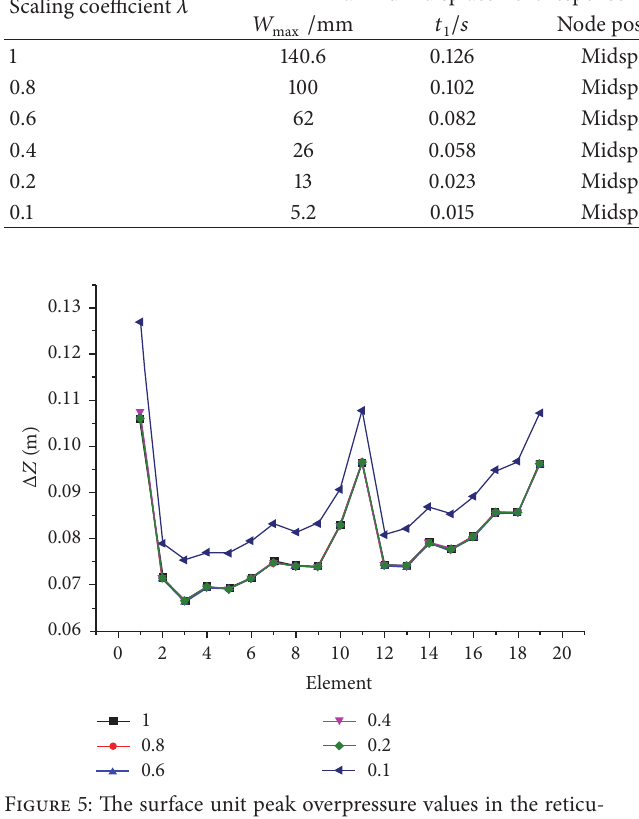
Figure 7: Time-history curve of maximum member stress in scaled models.